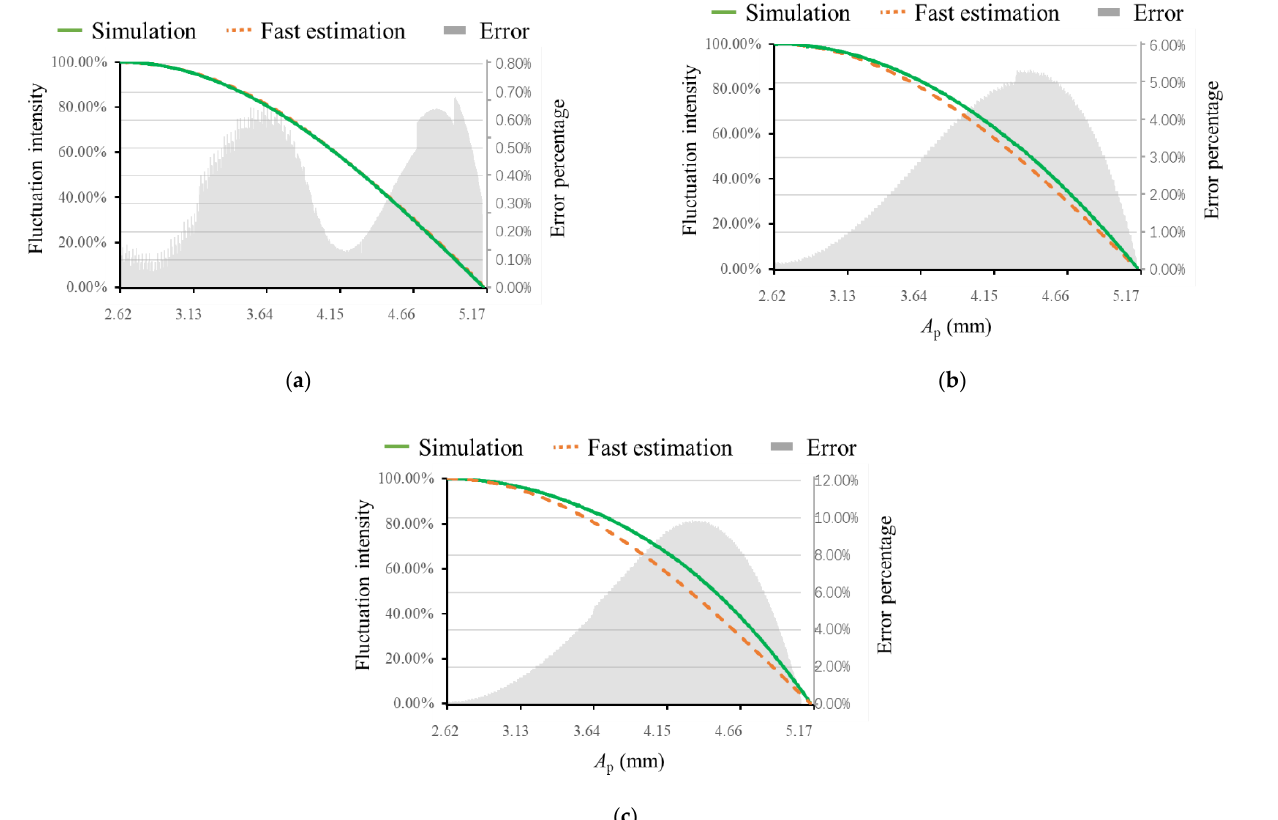
Figure 8. Comparison of the fast estimation method and the simulation method: ( a ) A e = 1.5 mm; ( b ) A e = 2.5 mm; and ( c ) A e = 3.5 mm. Table 1. Parameters for the force fluctuation simulation.